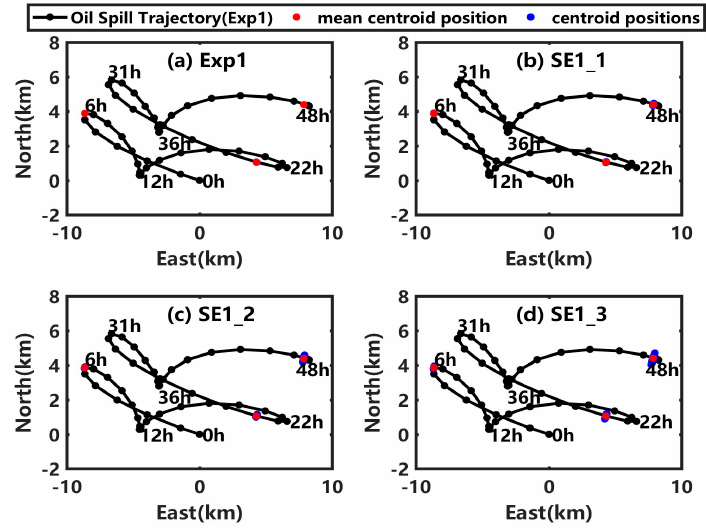
Figure 3. ( a ) Centroid positions of the simulated oil spill at the sea surface in 100 scenarios (blue dots) and the mean value (red dots) at 6 h, 24 h, and 48 h in Exp1. ( b – d ) are similar to ( a ), but for the sensitivity experiments SE1_1, SE1_2, and SE1_3. In each subplot, the black line with black dots is the averaged oil spill trajectory at the sea surface in Exp1.